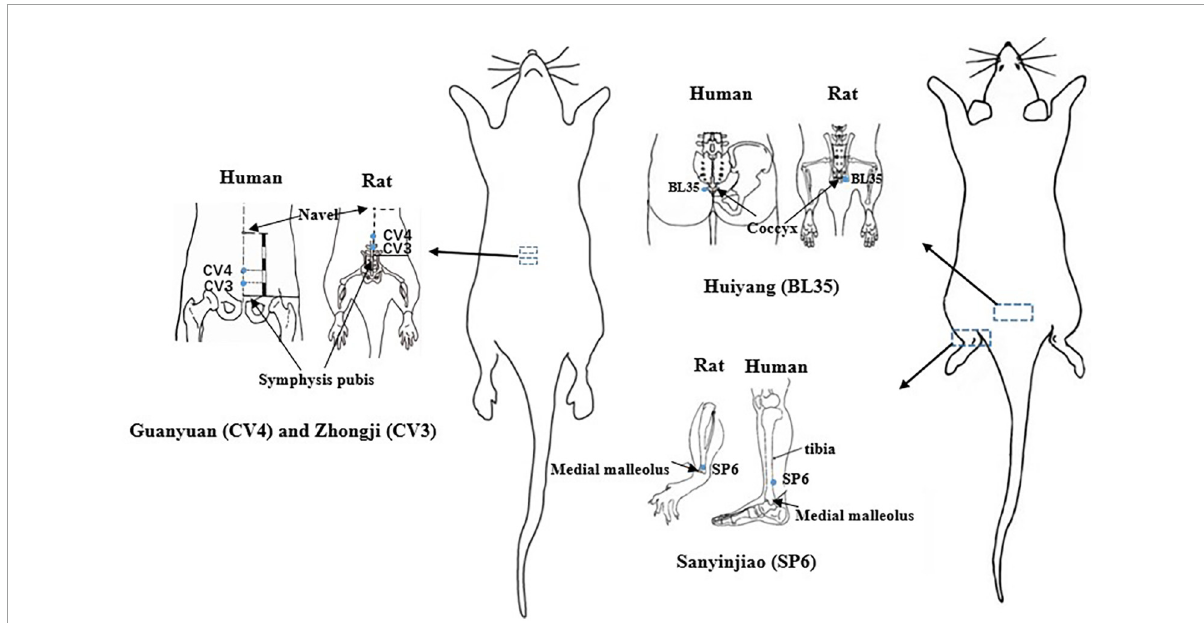
FIGURE11 Schematic representation of the points in the EA group. Anatomical localization of the acupoints are shown on the rat and human bodies. Points are indicated by blue dots.